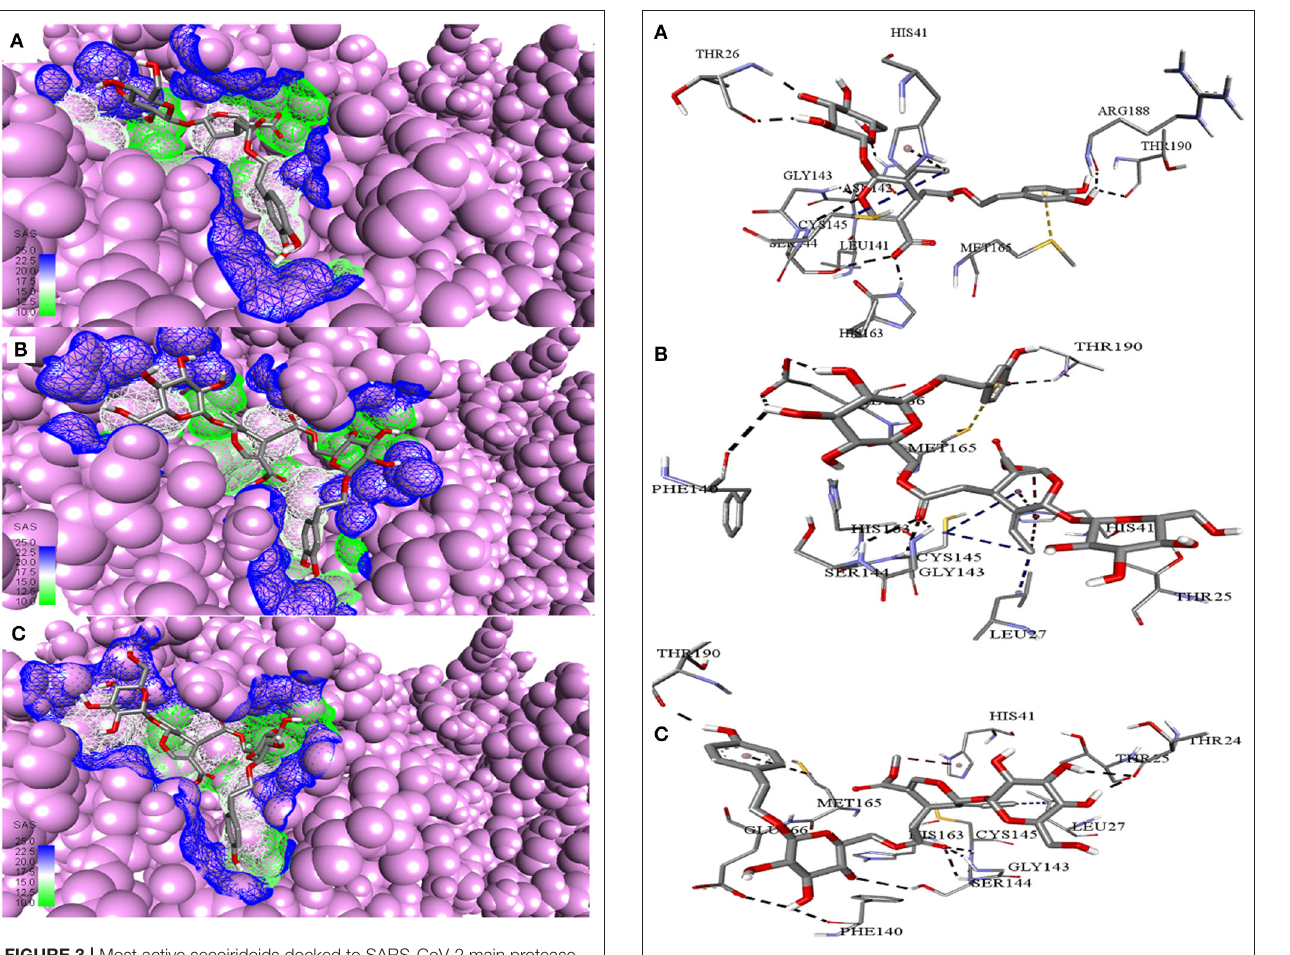
FIGURE 4 | Intermolecular interactions of (A) Demethyloleuropein (B) Neo-nüzhenide (C) Nüzhenide with SARS-CoV-2 main protease. Interaction with Cys145 of the M pro is considered crucial for inhibition. Nature of interactions: black—hydrogen bonds; yellow— π -sulfur; brown— π -alkyl; blue—alkyl-alkyl